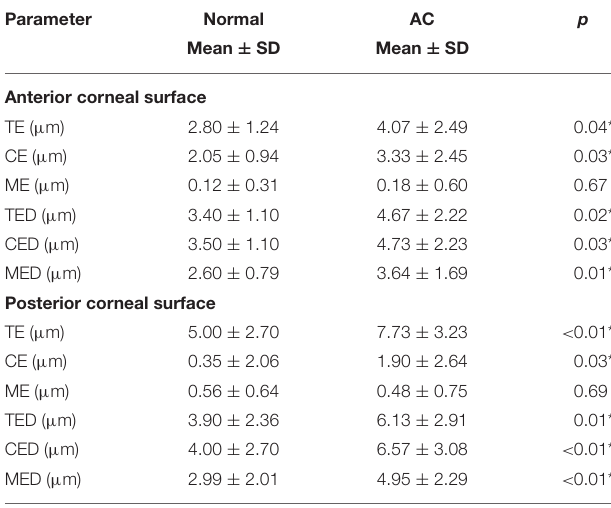
TABLE 4 | Comparison of corneal elevation parameters between the normal and AC